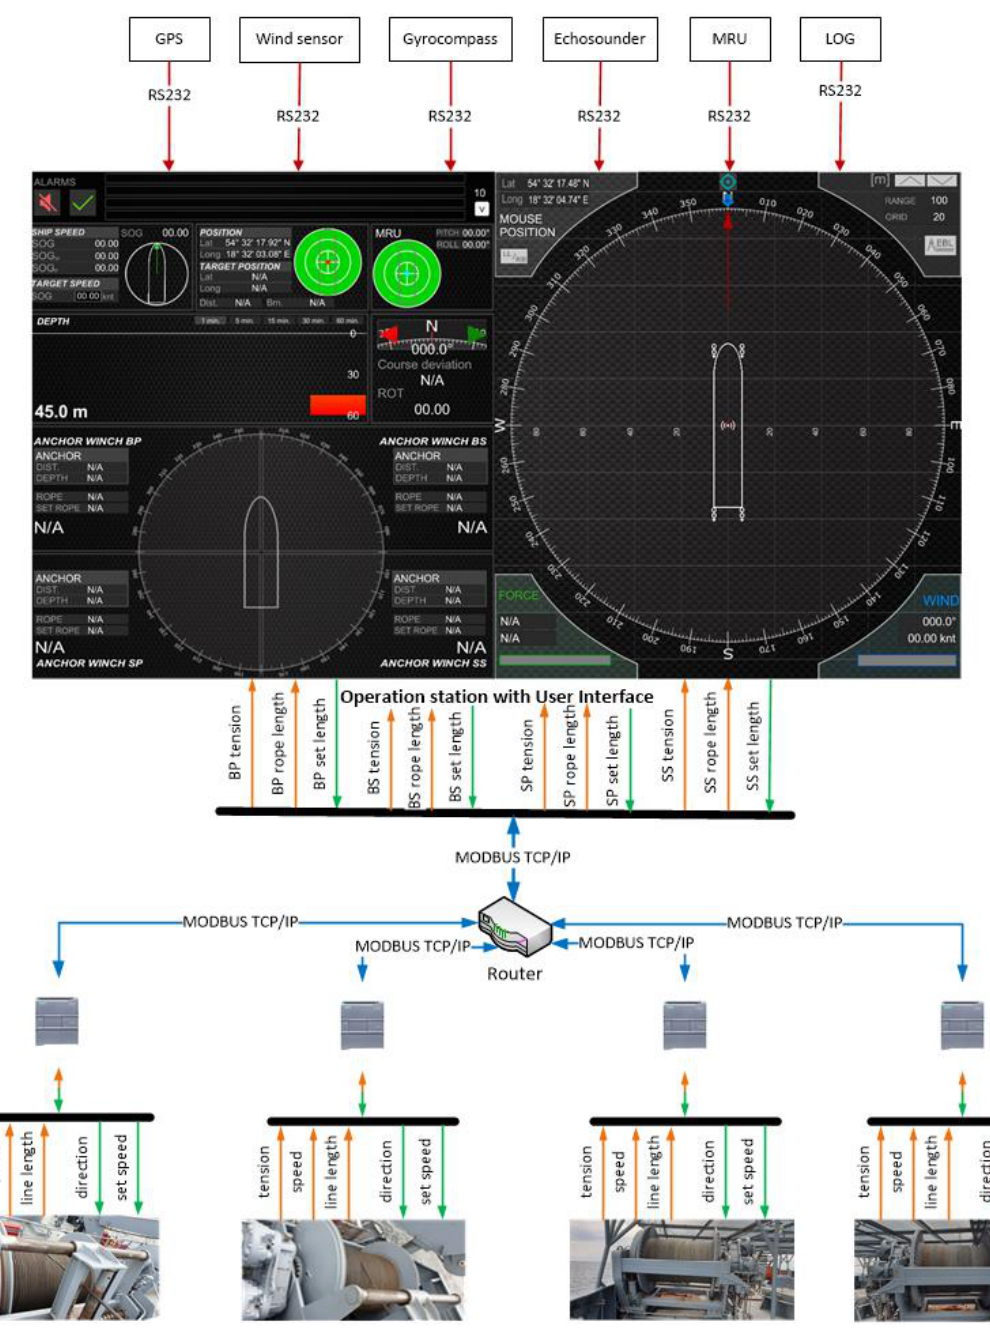
Figure 5. Diagram of the anchor-base positioning system. An enlarged user interface is shown in Figure